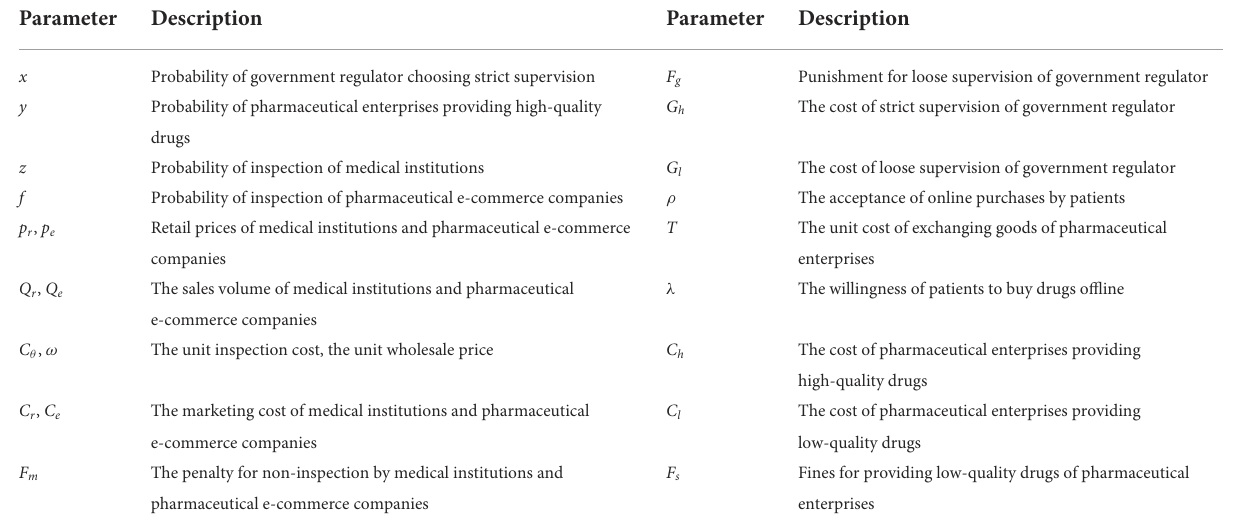
TABLE 1 Related parameter